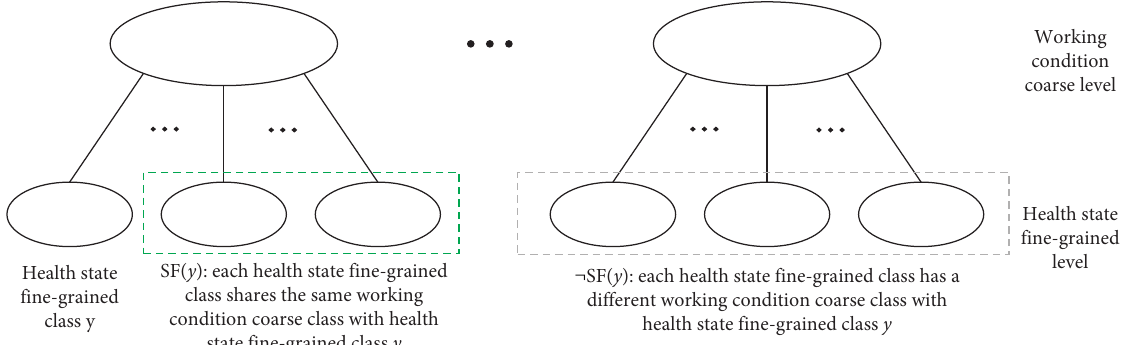
Figure 5: The hierarchical and the interclass structure of